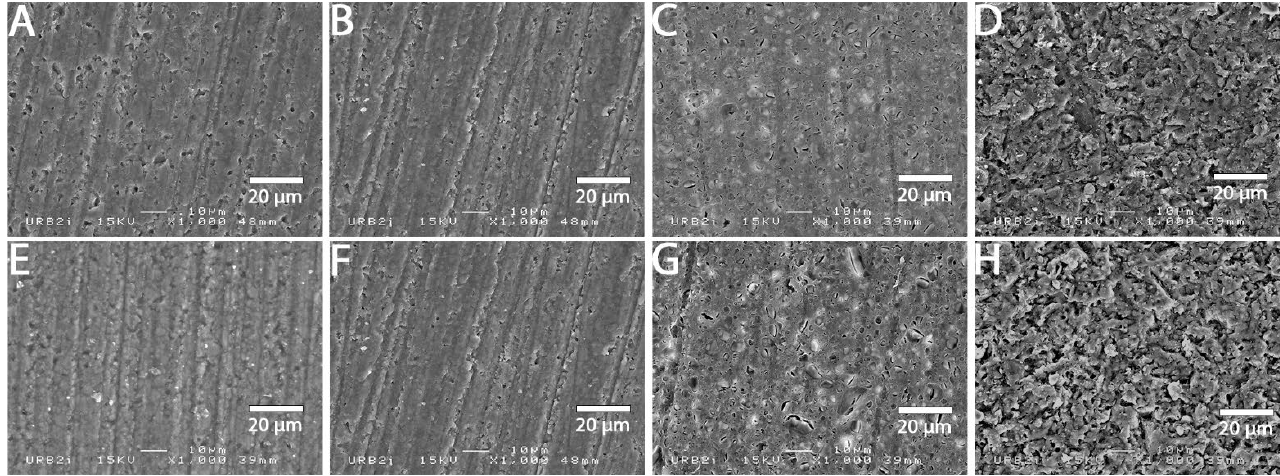
Figure 5. SEM micrograph for Lava Ultimate surface (×1000 magnification) with the different surface treatments: ( A ) control; ( B ) polyacrylic acid; ( C ) hydrofluoric acid; ( D ) sandblasting; ( E ) 800 grit polishing + universal primer; ( F ) polyacrylic acid + universal primer; ( G ) hydrofluoric acid + universal primer; ( H ) sandblasting + universal primer. Sandblasting surface treatment ( D , H ) shows a more irregular pattern surface than the other ones.